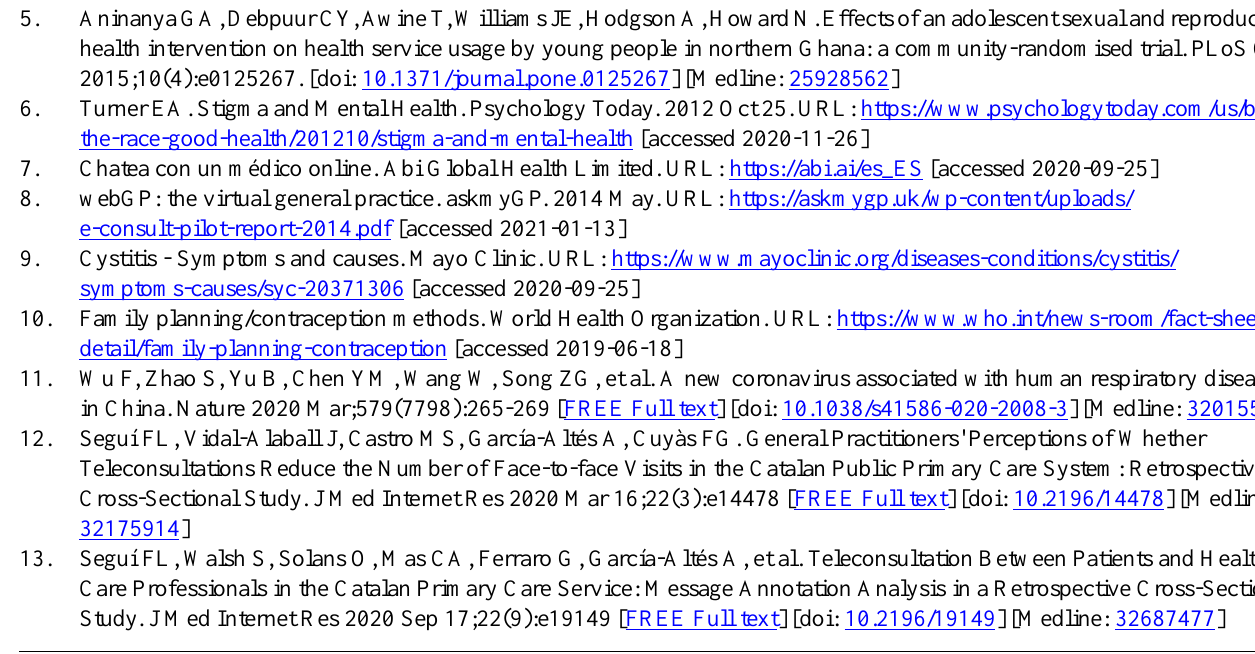
Abbreviations AGH: Abi Global Health CONSORT: Consolidated Standards of Reporting